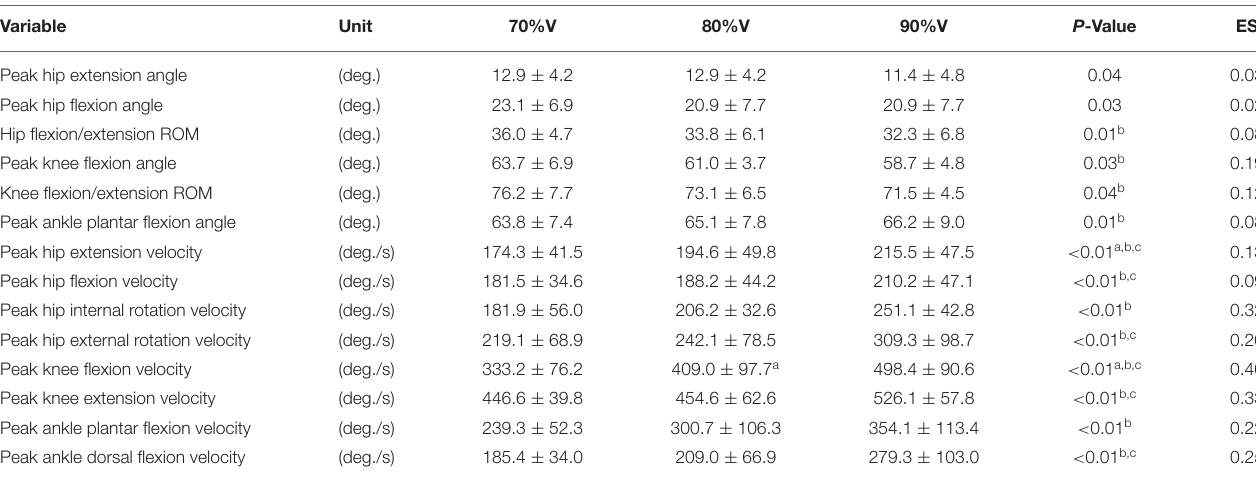
TABLE 2 | Summary of peak joint angle, range of motion (ROM), and peak joint angular velocity in the 70, 80, and 90%V trials.